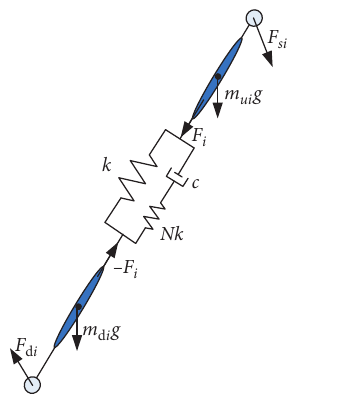
Figure 3: Force analysis diagram of the i th